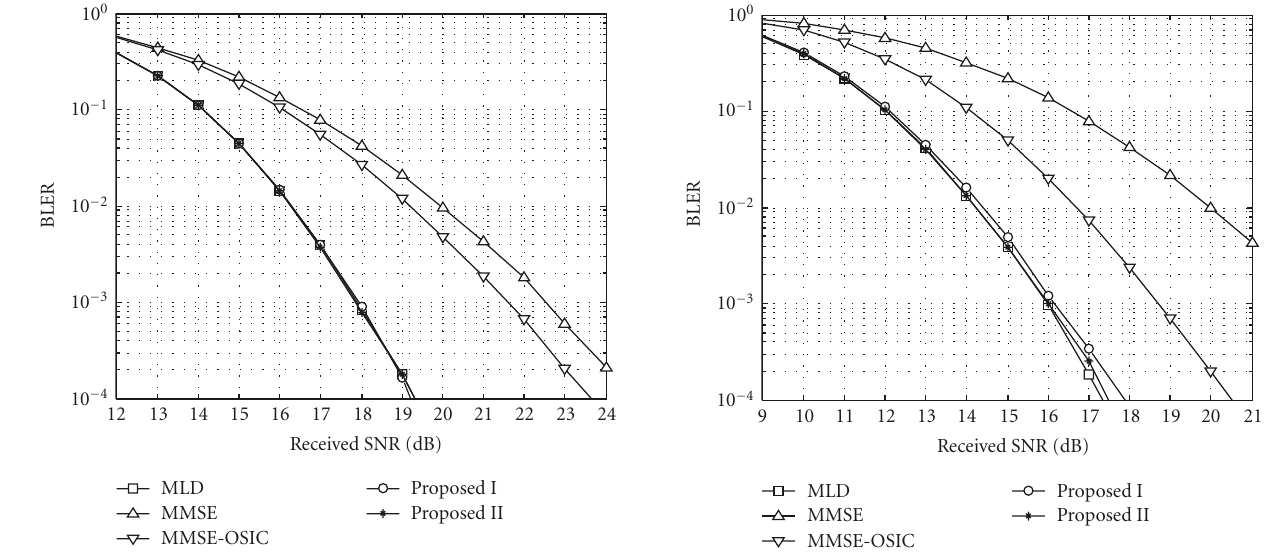
forum mobile RCT, which is based on the performance of ML, the whole system can achieve a higher margin of implementation loss.